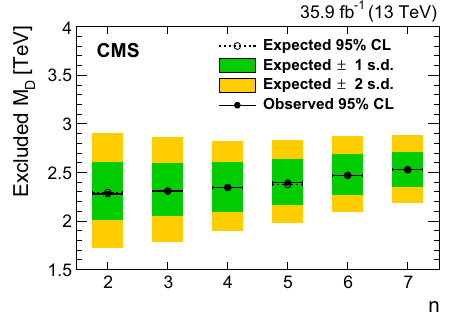
Fig. 11 Expected and observed 95% CL cross section exclusion limits for the example case n = 4 in the ADD scenario (left) and exclusion limits on M D for different values of n (right). In both plots, the markers for the expected exclusion are obscured by the close overlap with those for the observed exclusion. The red solid line in the left plot shows the